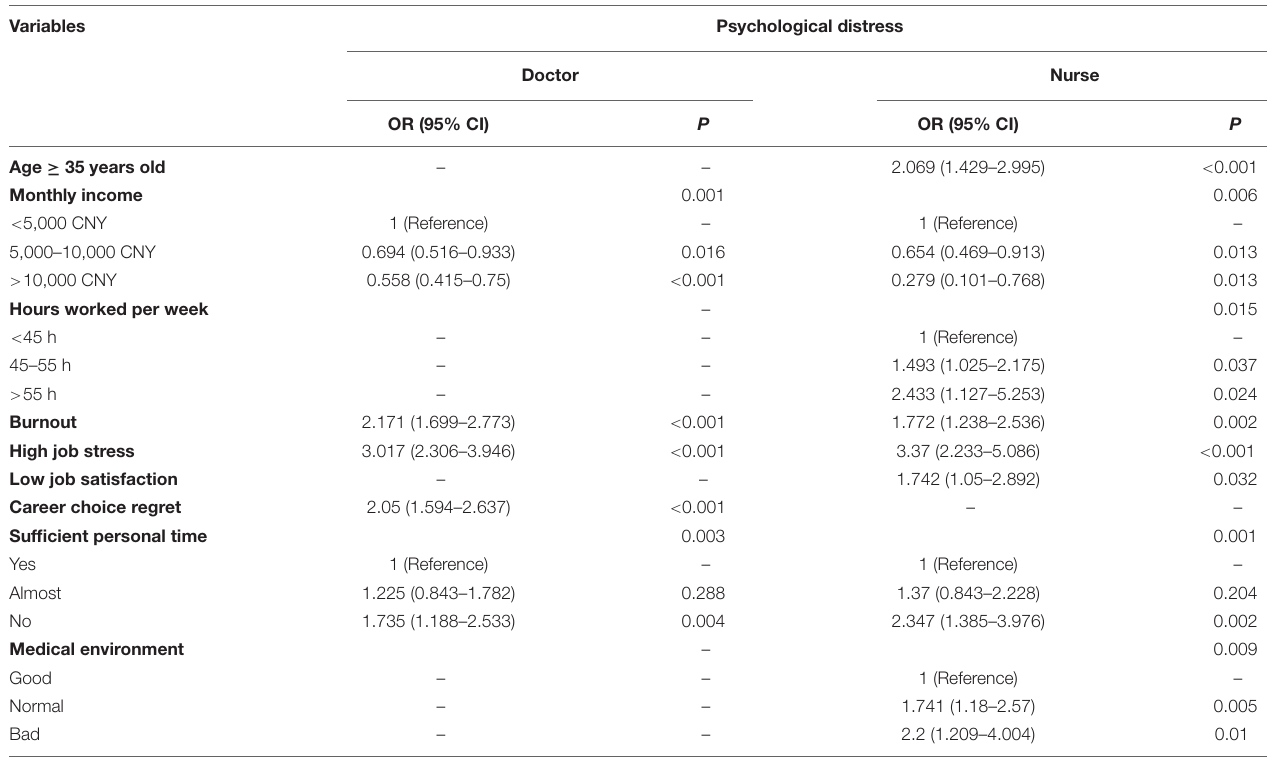
TABLE 3 | Multivariable analysis of psychological